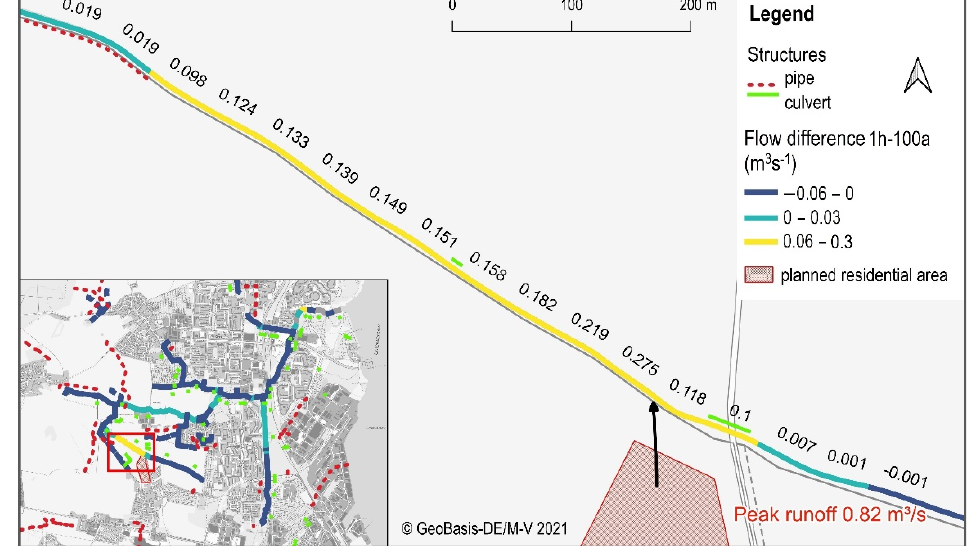
Figure 9. Flow difference (m 3 s − 1 ) in the immediate area of the discharge point for the rain event 1 h–100 a simulated with SWMM.